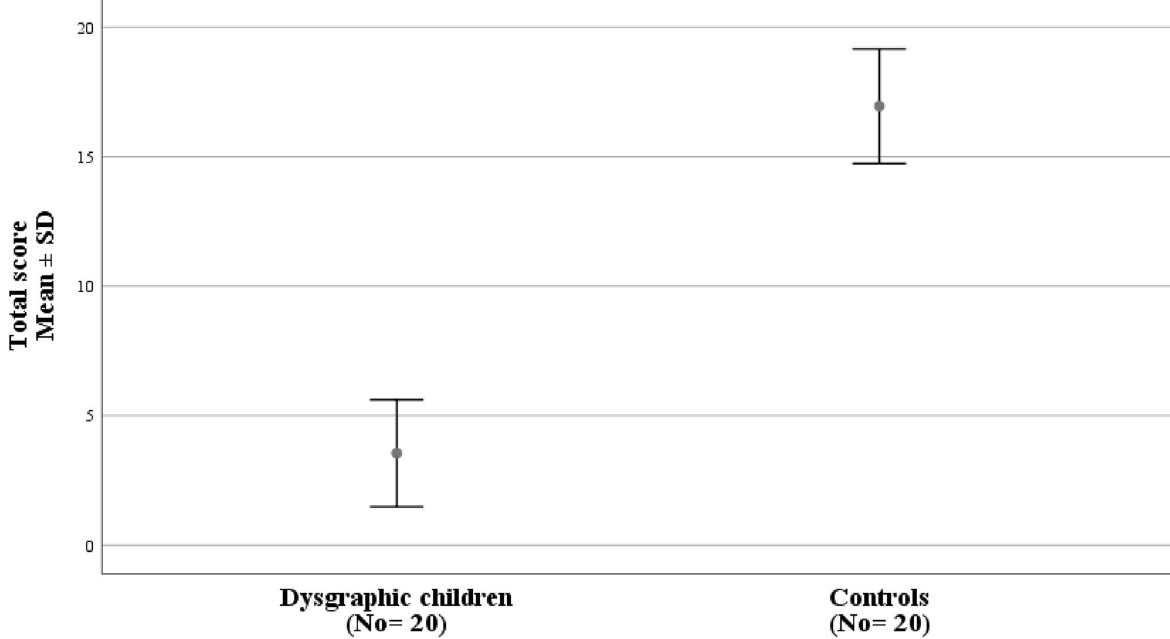
Fig. 1 Comparison between studied sample groups (cases vs controls) according to total